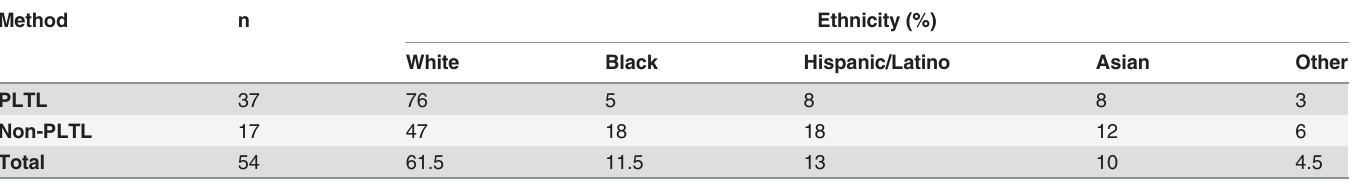
Table 2. Demographics pro fi le for PLTL and Non-PLTL Groups (Ethnicity).